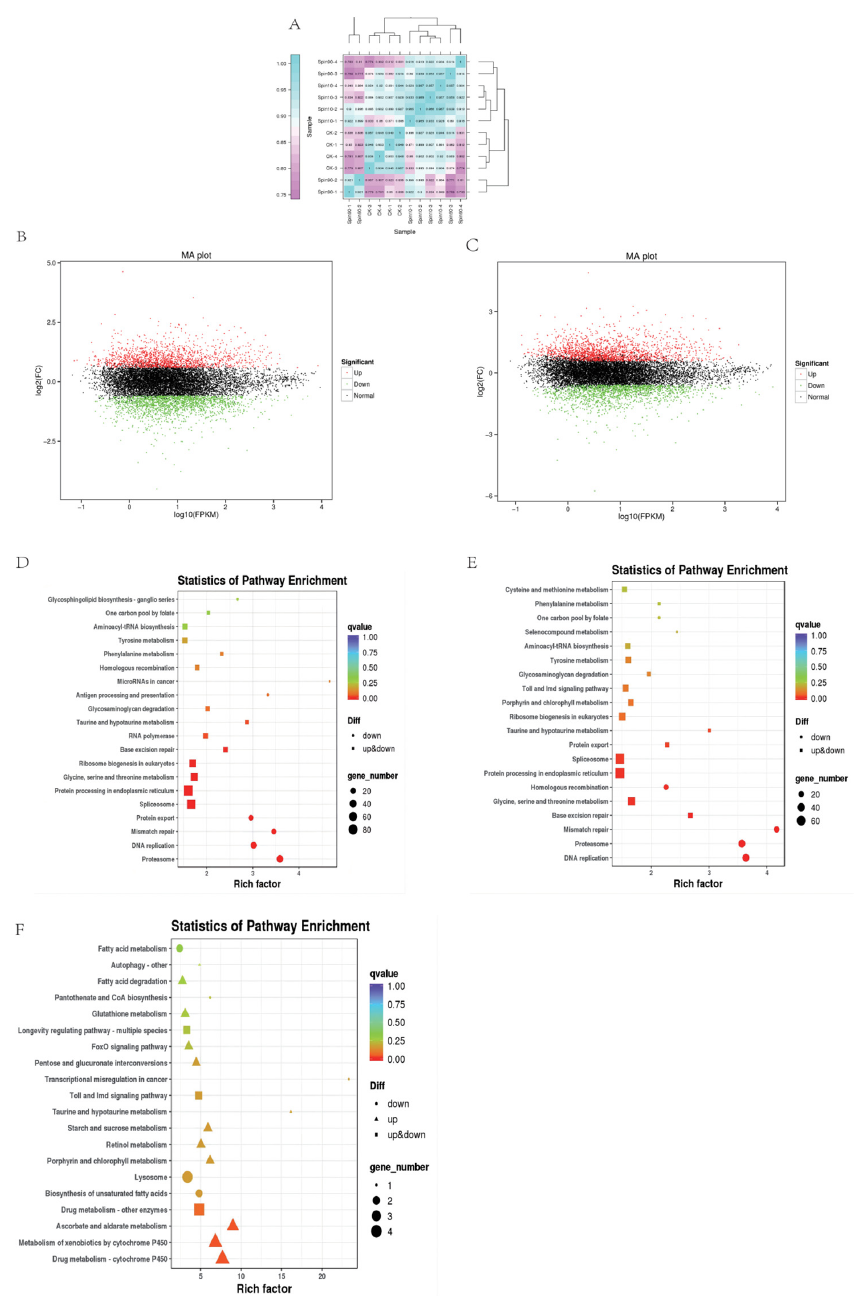
Figure 1. Transcriptome response of S. frugiperda to spinetoram stress. ( A ) Pearson’s correlation coefficient analysis. ( B , C ) Derived from volcano plots of transcriptome in Control vs. LC 10 and Control vs. LC 90 , respectively. KEGG pathways in Control vs. LC 10 ( D ), Control vs. LC 90 ( E ), and LC 10 vs. LC 90 ( F ). Metabolic profiles of S. frugiperda in response to spinetoram treatment. Both positive and negative ion modes of ESI were used during LC-MS/MS analysis.